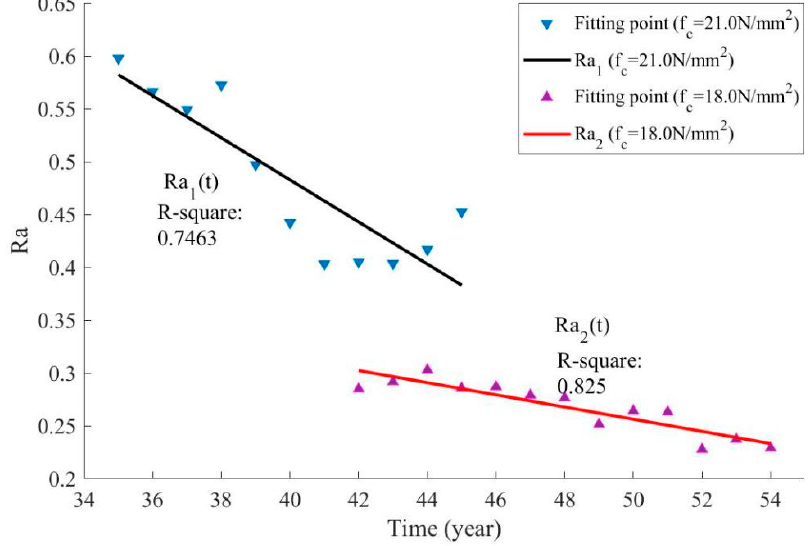
Figure 6. Fitting of the ratio of the relative concrete strength to the mean value of carbonation depth.